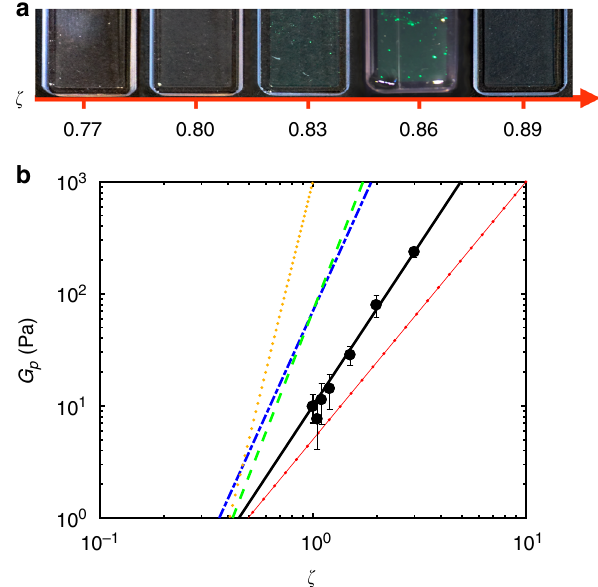
Fig. 2 Phase behavior and G ′ plateau of suspensions of ultra-low crosslinked (ULC) microgels. a Image of a series of samples of ultra-low crosslinked microgels of increasing volume fraction in water. b Plateau value of G ′ , G p (black circles), versus the generalized volume fraction, ζ . Black line: data fi t with G p ∝ ζ m . Dotted, dashed, dotted-dashed and line- with-dots lines are taken from refs. 1,11,32,33 , see text for